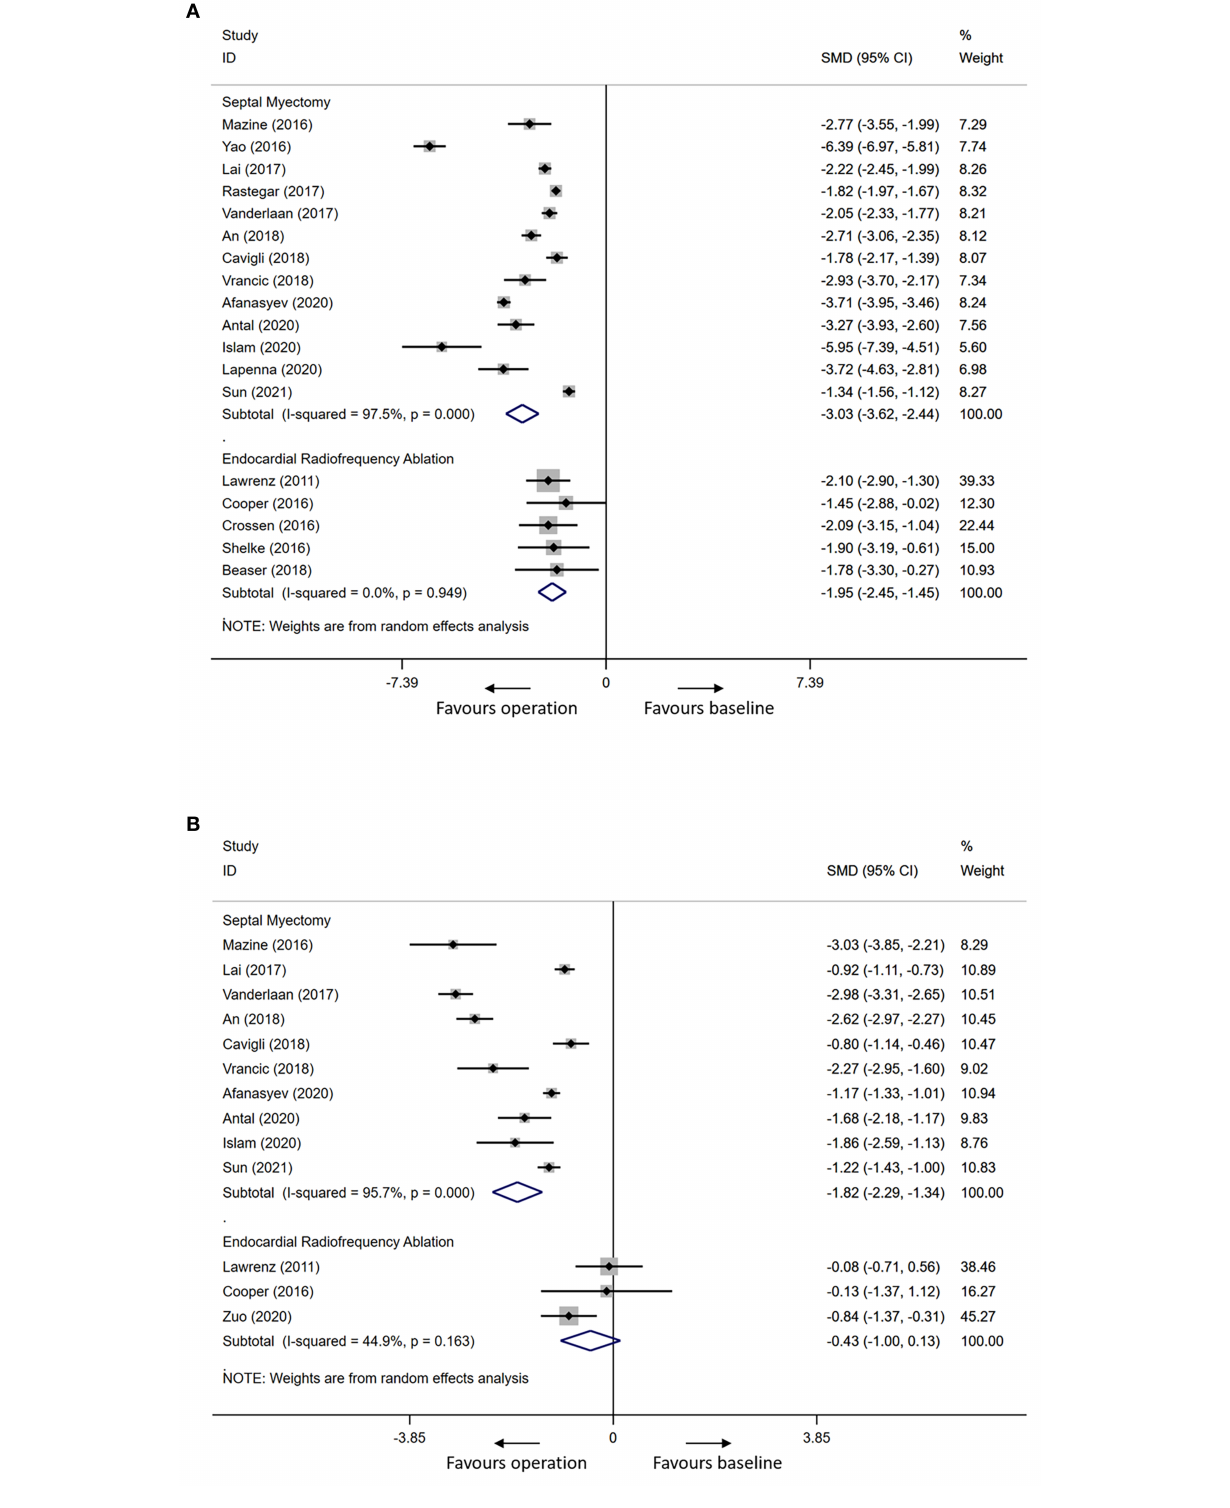
Frontiers in Surgery |